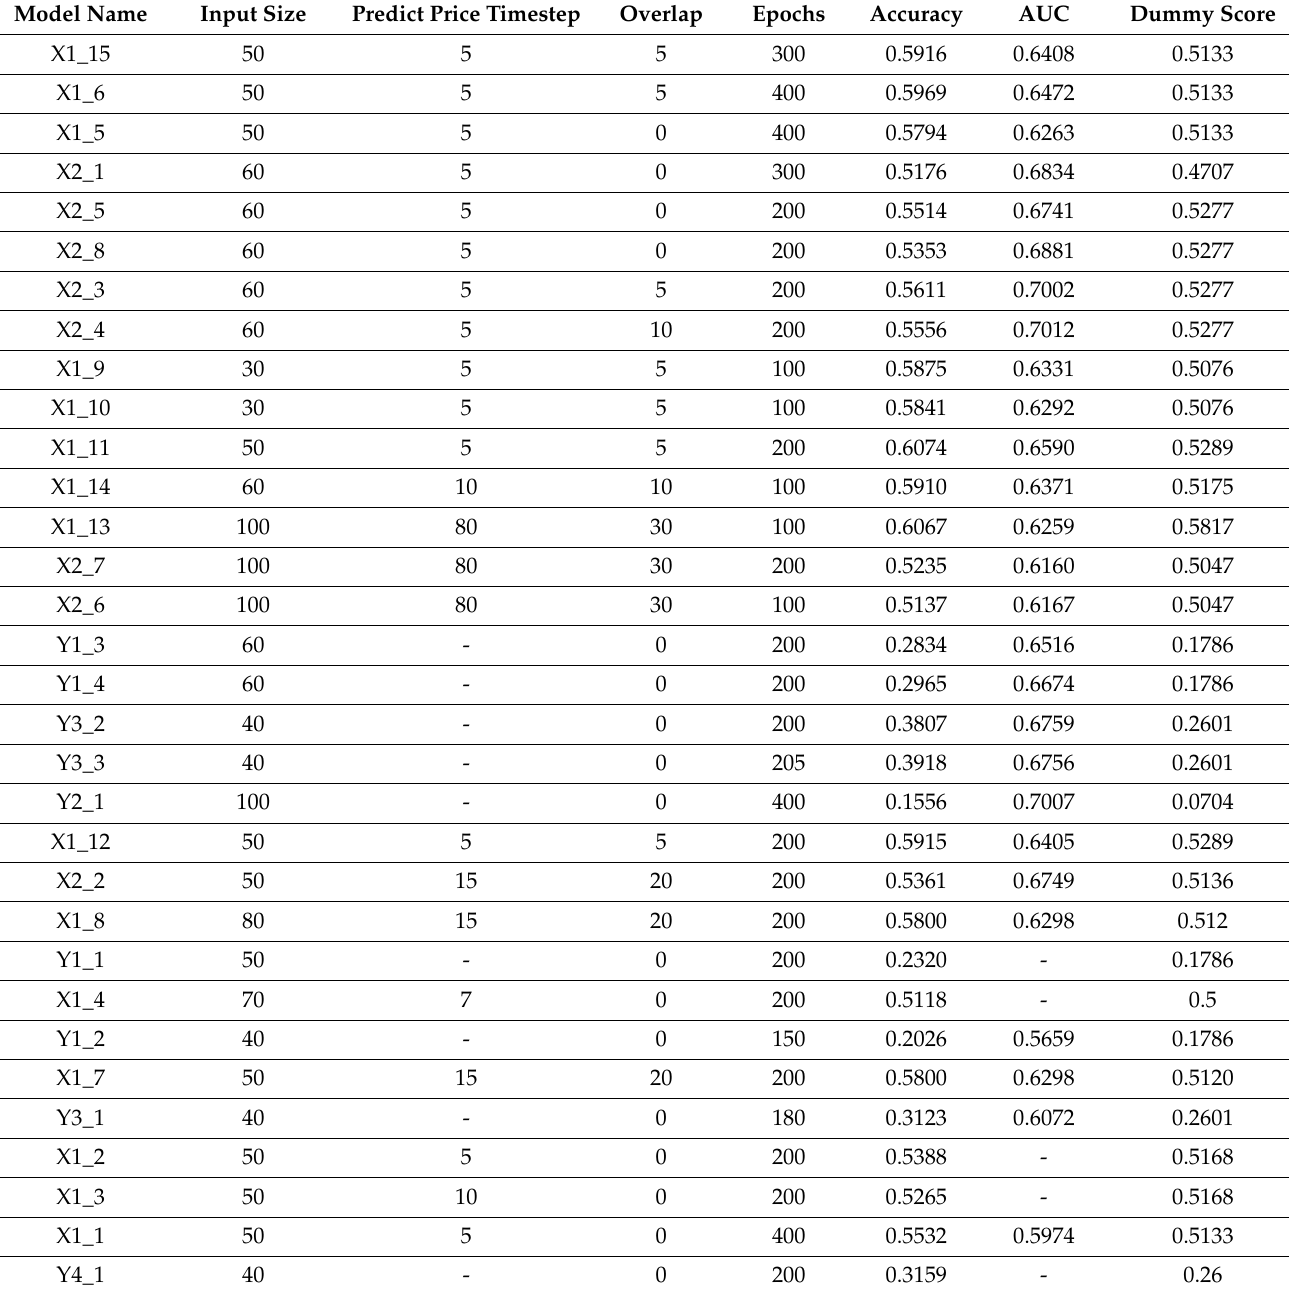
Table A2. The model output and input sizes predict price time-steps, overlap, epochs trained, accuracy, AUC, and dummy scores. Only price classifiers have defined predict price time-steps. Overlap indicates whether the training and validation dataset time-series could overlap within observations during the data preparation